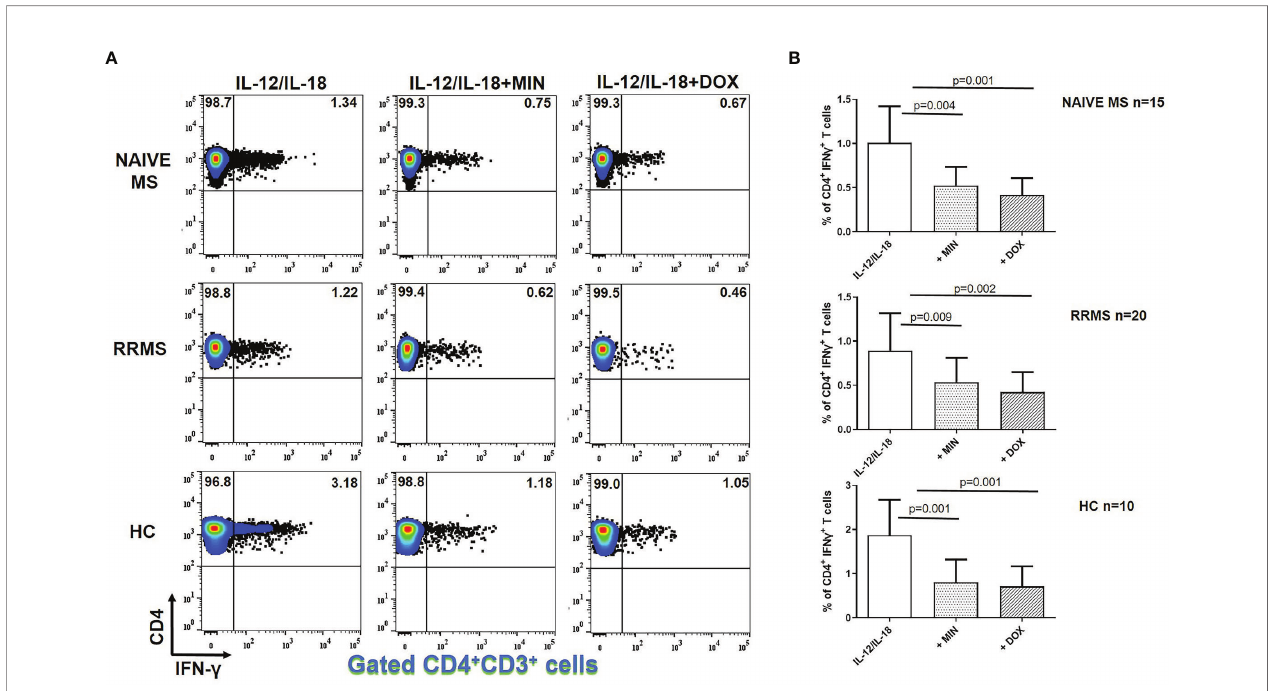
FIGURE 1 | Tetracycline-mediated inhibition of CD4 + IFN g + T cells. PBMCs from naïve MS patients (n=15), RRMS patients (n=20) and HCs (n=10) were seeded in cell culture plates (1 x 10 6 per well) and stimulated with IL-12 plus IL-18 (IL-12/IL-18), IL-12/IL-18 plus minocycline (MIN) and IL-12/IL-18 plus doxycycline (DOX) for 5h. Cells were collected, washed, surface stained with appropriate monoclonal antibodies an analyzed for intracellular IFN- g production by fl ow cytometry (see also methods section). Individual cell subsets were sub-gated according to expression of CD3 and CD4 surface epitopes. (A) Flow cytometry dot-plots showing the frequency of CD4 + IFN g + T cells in IL-12/IL-18, IL-12/IL-18/MIN and IL-12/IL-18/DOX treated cells from representative MS cases and HCs. (B) Box and whiskers graphical representation showing signi fi cant reduction in the percentages of IFN- g -producing CD4 + T cells in the presence of tetracyclines in naïve MS, RRMS and